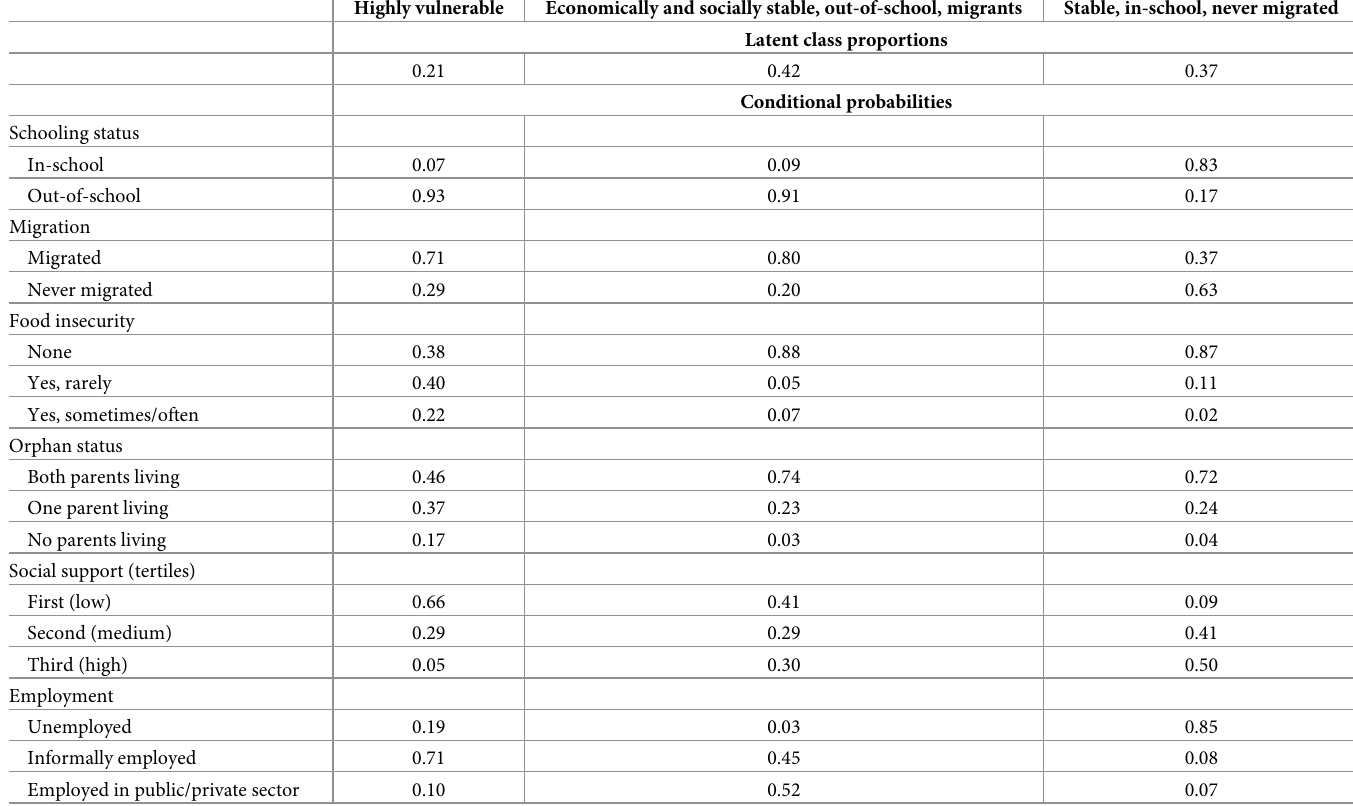
Table 2. Latent class proportions and conditional probabilities for a 3-class model among 1,501 adolescent girls and young women (AGYW) in Ethiopia aged 15– 24,